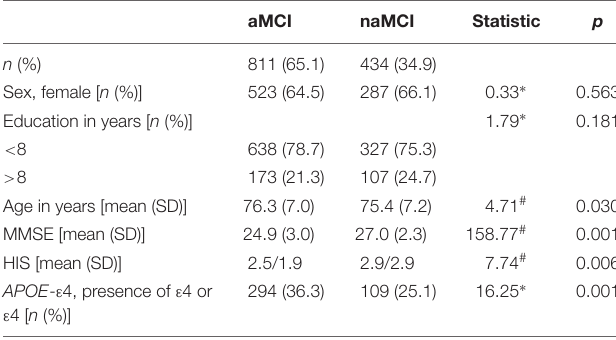
TABLE 1 | Comparison of demographic, clinical, and APOE- ε 4 data between patients with aMCI and naMCI phenotypes from the ACE